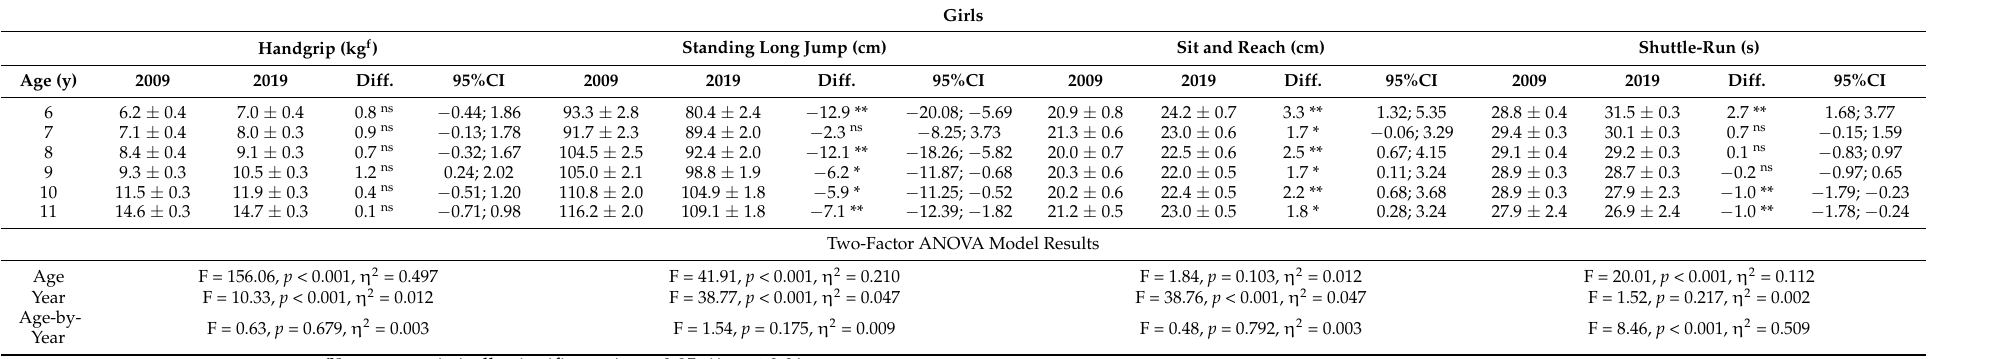
Table 3. Descriptive statistics (means ± standard errors), differences (diff), and their corresponding 95% confidence intervals (95%CI) for each physical fitness test in girls between 2009 and 2019 cohorts. Girls